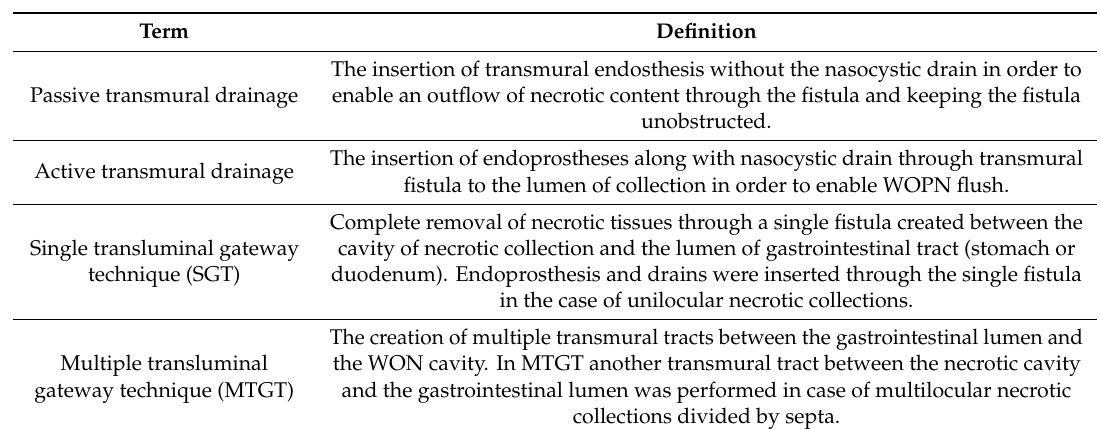
Table 1. Definitions